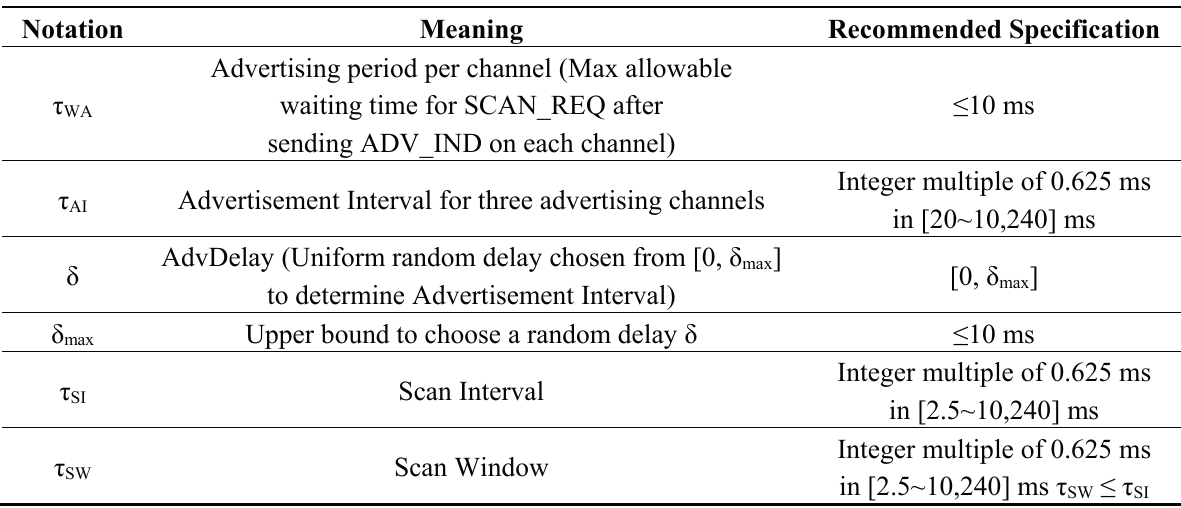
Table 1. List of major timing